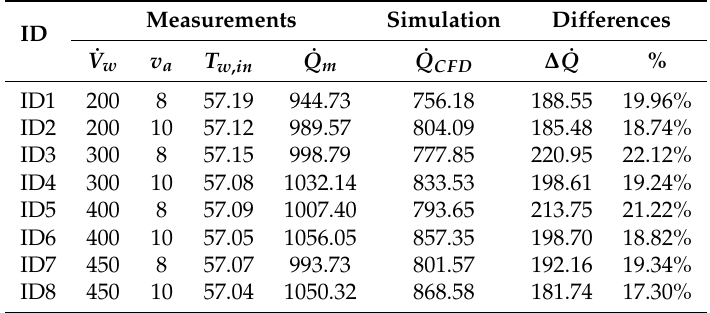
Table 7. Comparison of measurements and numerical simulations.